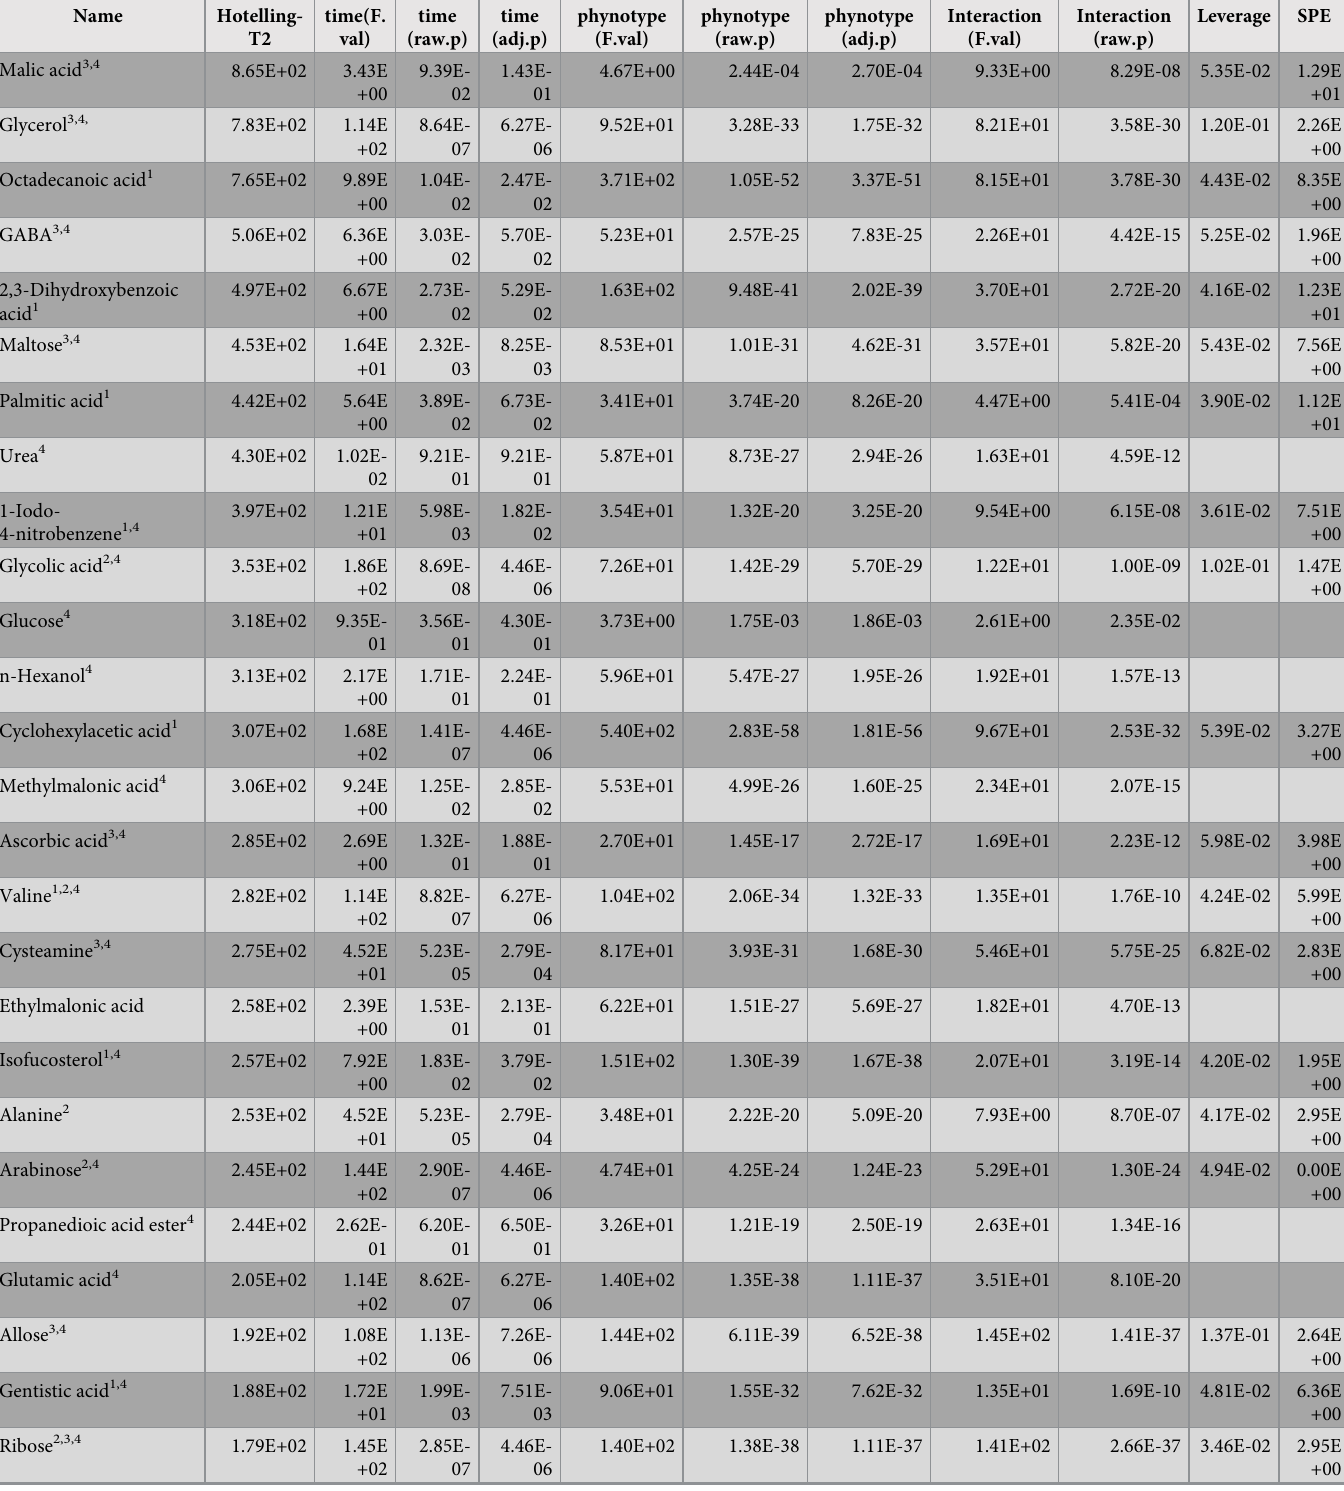
Table 2. Metabolites of U . prolifera which met the following criteria: potential biomarker according OPLS-DA, well-modeled by SPE and with Hotelling’s T2 value > 100.